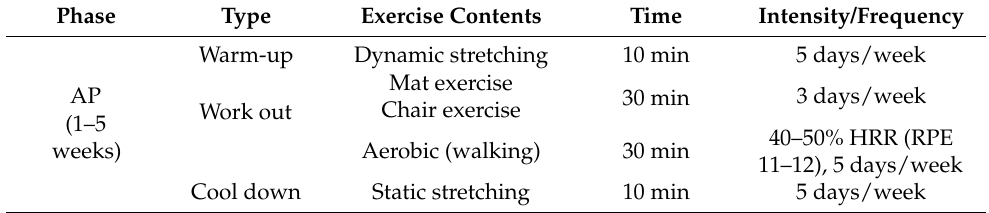
Table 2. The 15-week complex exercise program for elderly woman with sarcopenia and osteoarthritis.